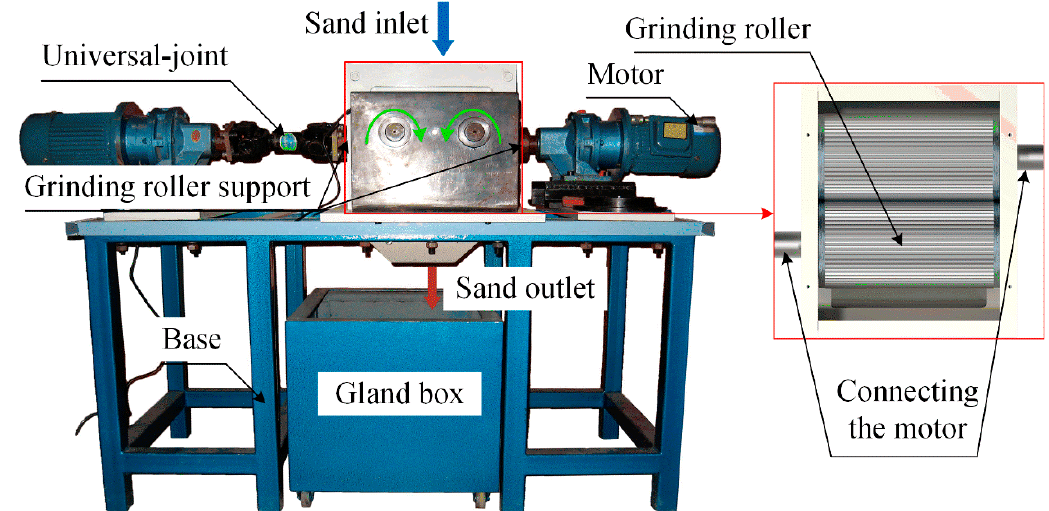
Figure 2. Experimental device.